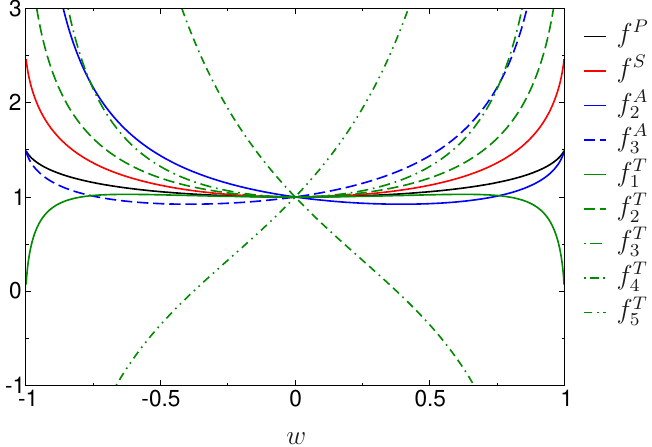
Figure 1 . Asymmetry functions for pseudoscalar, scalar, axial-vector, and tensor mesons. All functions are normalized to their value at w = 0.